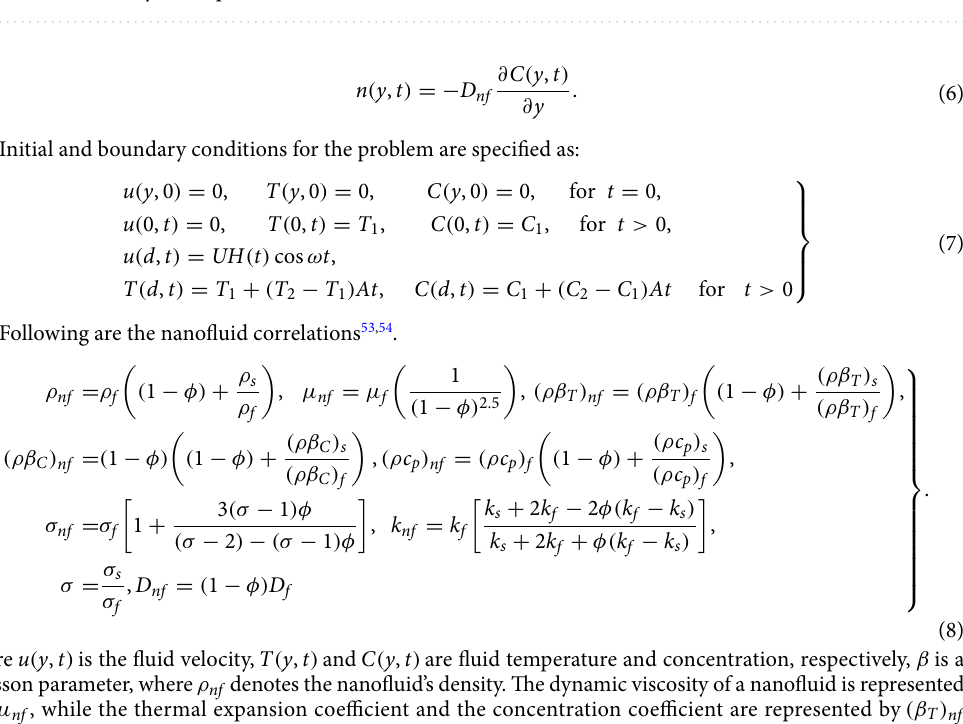
Figure 1. Geometry of the